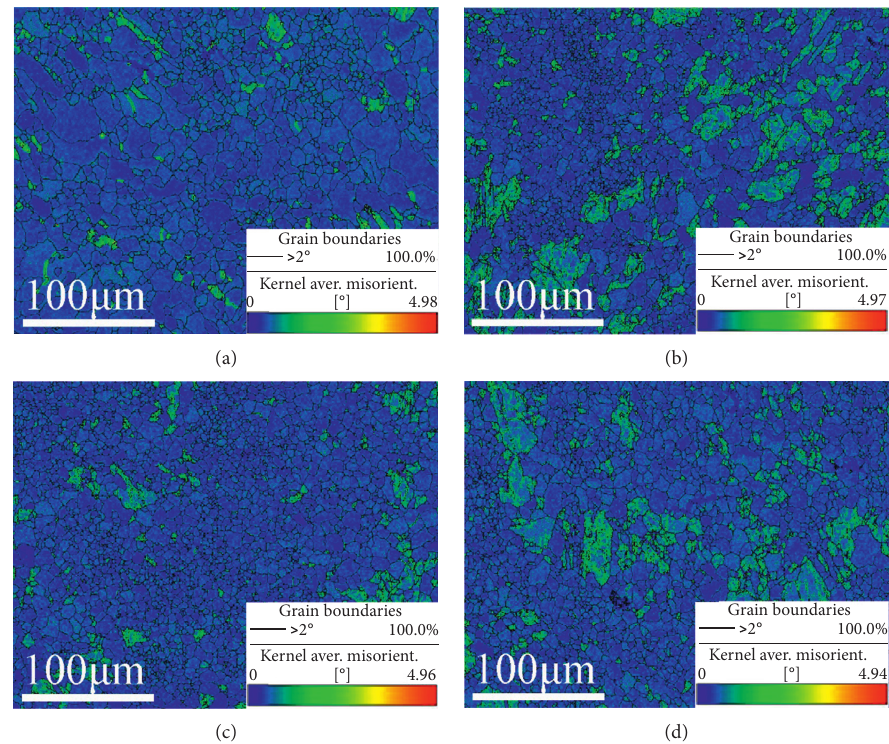
Figure 8: Kernel Average Misorientation maps of the as-rolled Mg-6Sn-3Al-1Zn alloys at different rolling temperatures: (a) 300 ° C, (b) 350 ° C, (c) 400 ° C, and (d) 450 °